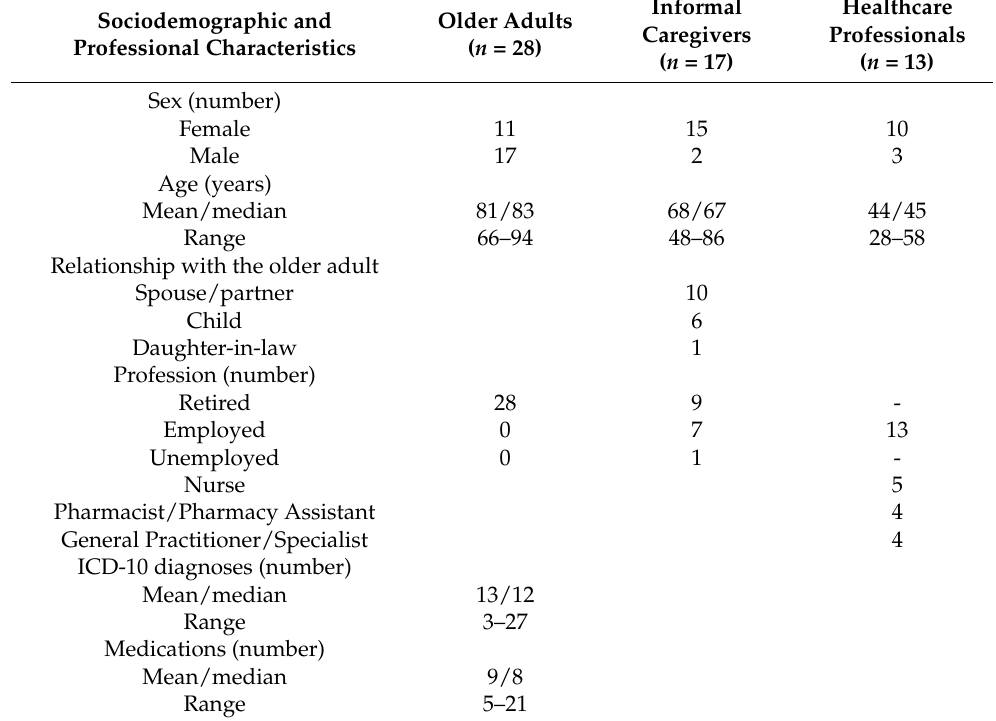
Table 3. Participants’ sociodemographic and professional characteristics and older adults’ numbers of prescribed medications and ICD-10